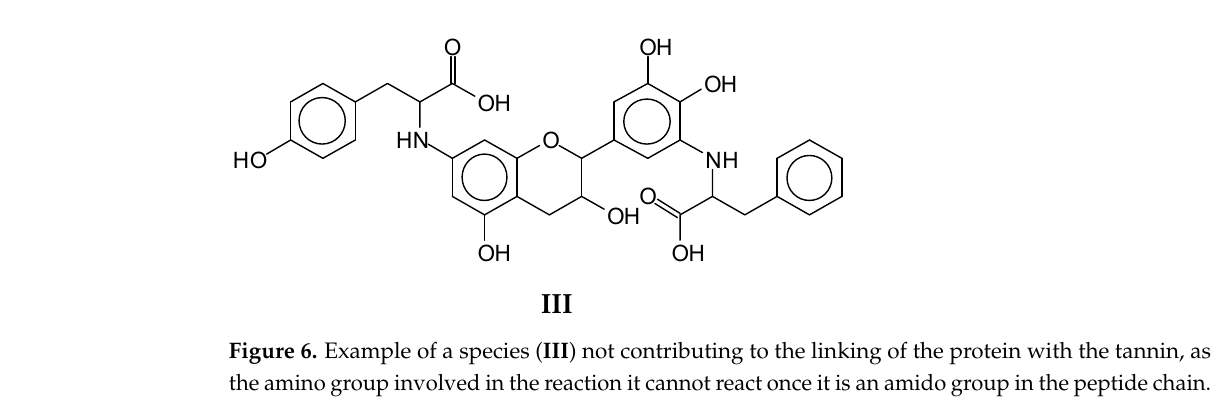
Figure 6 . Example of a species ( III ) not contributing to the linking of the protein with the tannin, as the amino group involved in the reaction it cannot react once it is an amido group in the peptide chain.